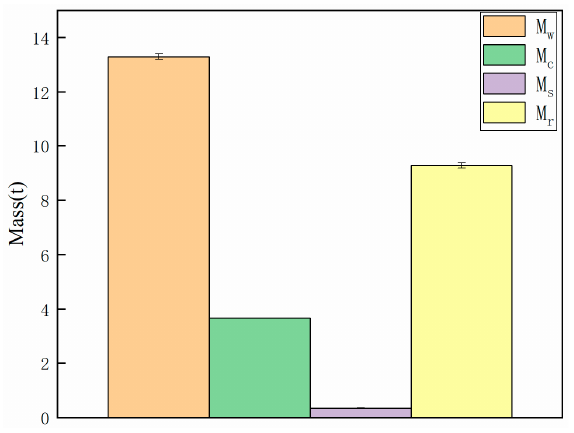
Figure 4. Wastewater mass